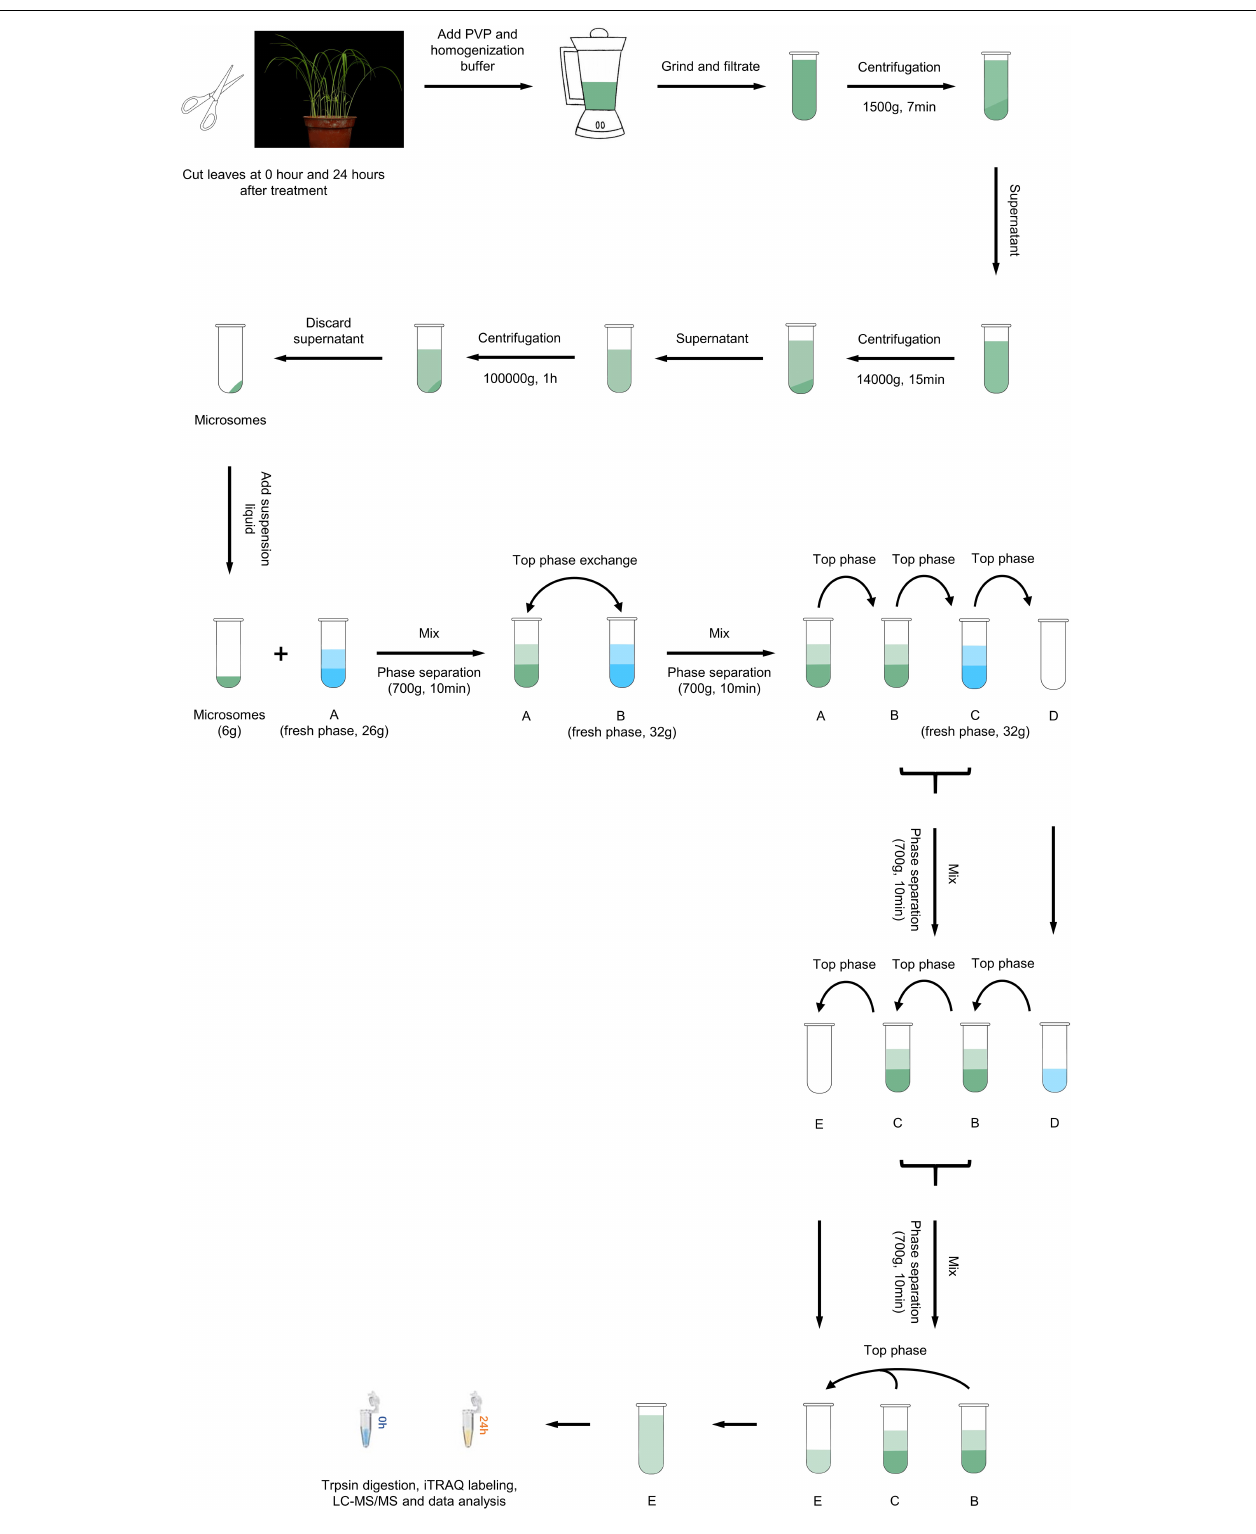
FIGURE 1 | Overview of the experimental scheme. Schematic representation of the proteomics workflow. Leaf samples were collected at 0 and 24 h after M. oryzae infection from the resistant rice landrace Hei. Total PM protein was extracted, digested and quantified via iTRAQ labeling and LC–MS/MS analysis. Bioinformatic analyses were used to explore the constitution and function of